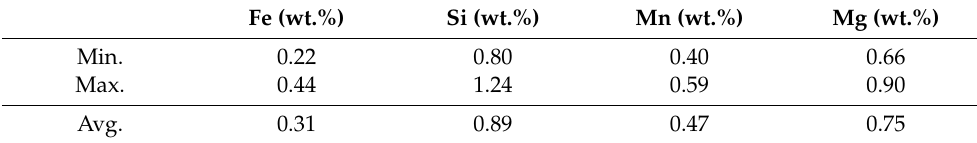
Table 3. Minimum, maximum, and average values of chemical composition. Fe (wt.%)